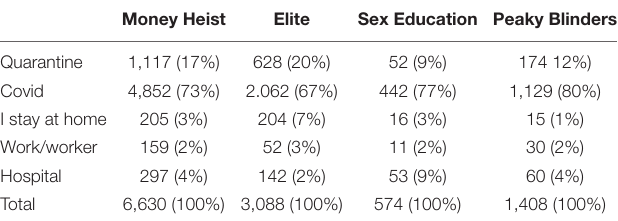
TABLE 5 | Frequencies and percentages of mentions regarding the coronavirus